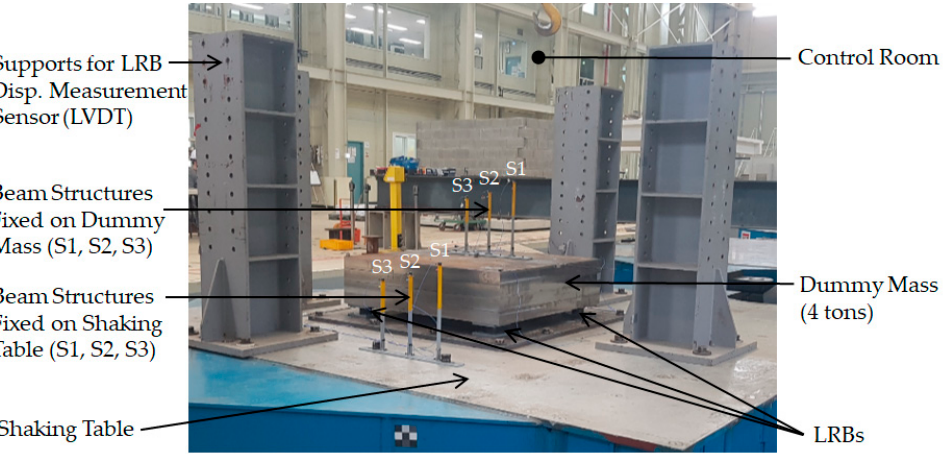
Figure 1. Photos of test mockup with four LRBs and four tons dummy mass system.